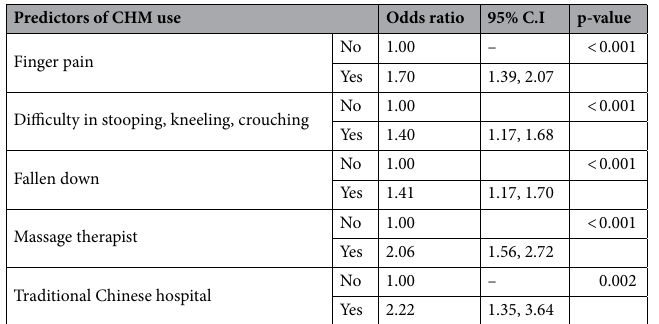
Table 4. Logistic regression identifying the statistically significant predictors of CHM use by Chinese women with arthritis.